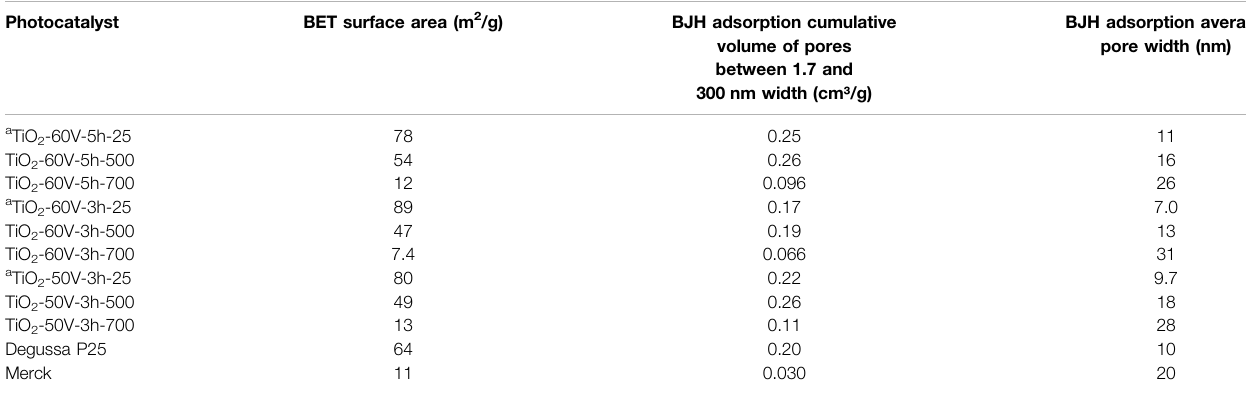
TABLE 2 | BET speci fi c surface area, pore volume and pore width values of the TiO 2 samples.